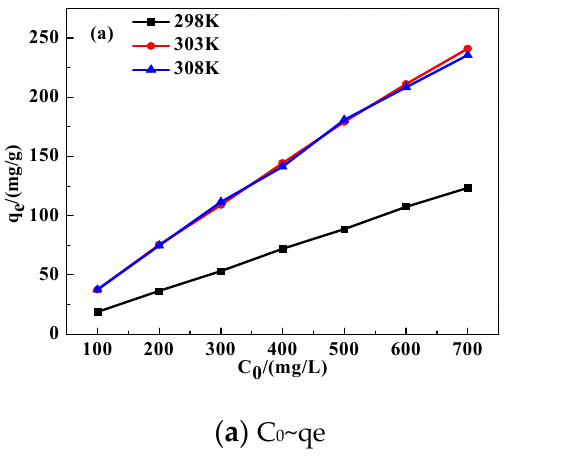
Figure 15. The effect of initial concentration of MG on ( a ) adsorption capacity and ( b ) adsorption removal rate at different temperatures.